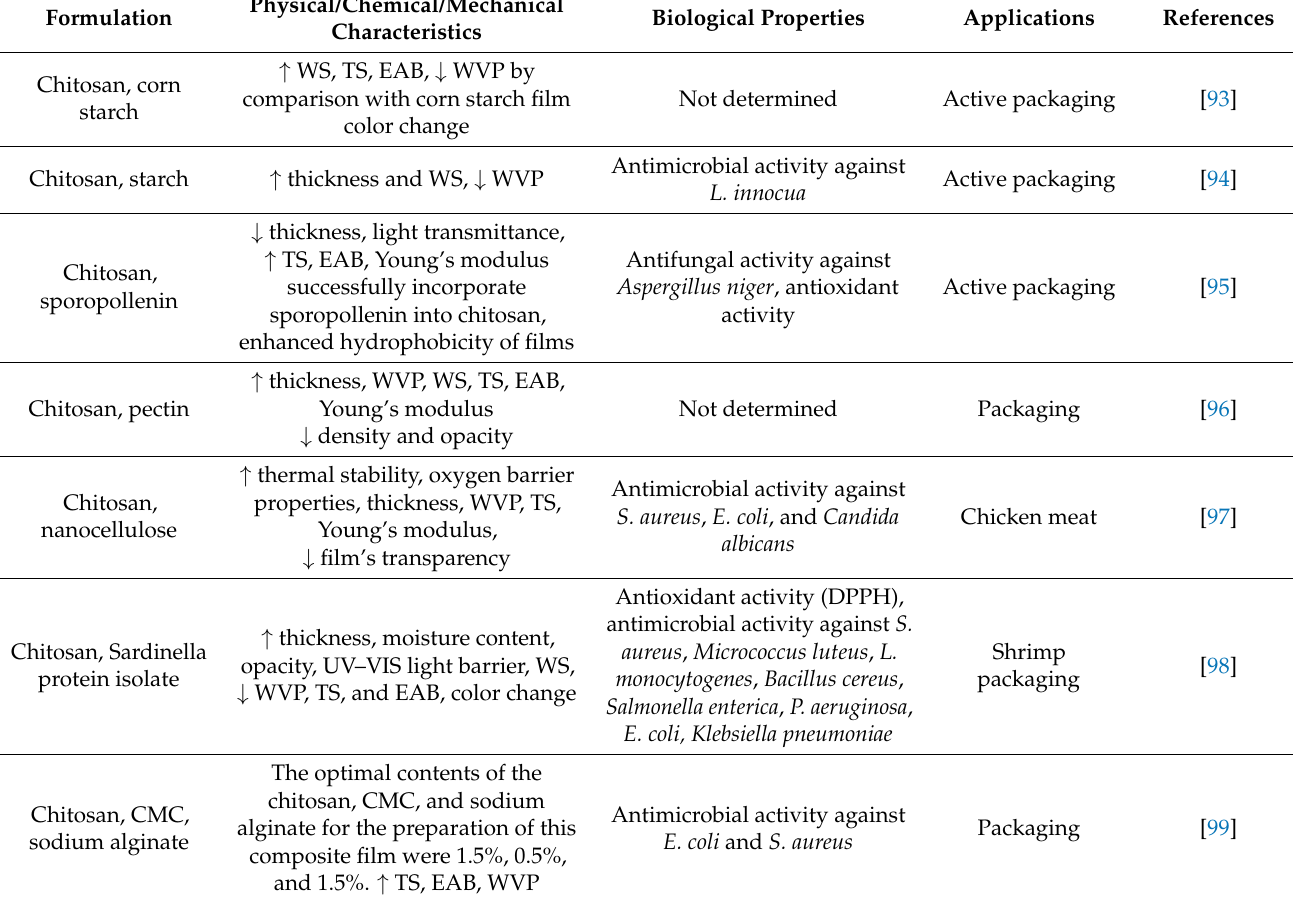
Table 4. The characteristics of the chitosan–biopolymers